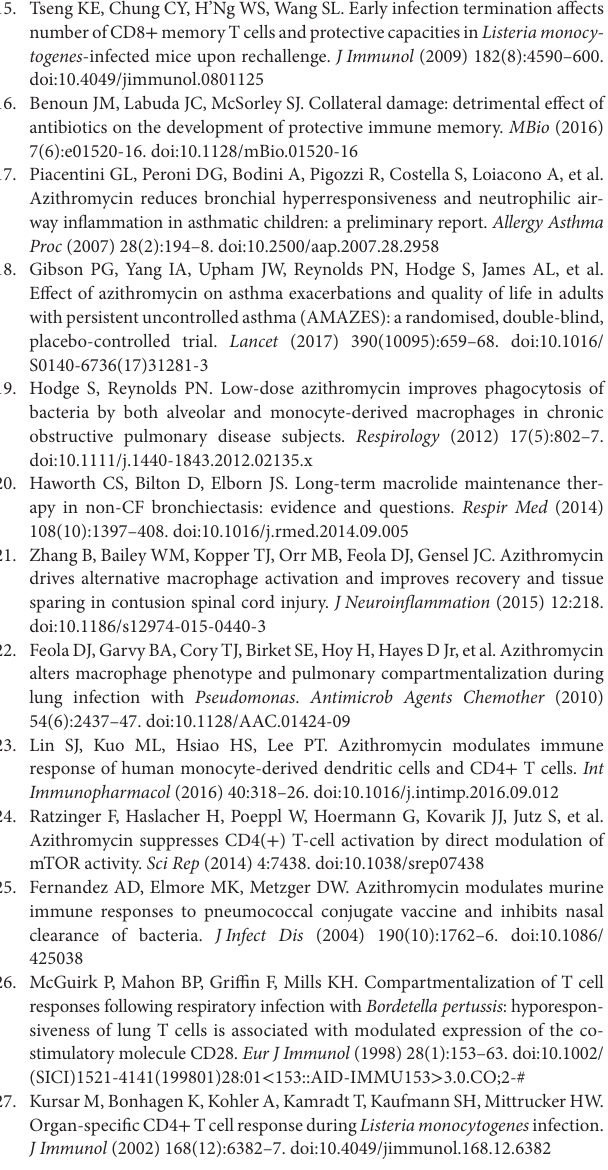
FigUre s1 | Gating strategy for innate immune cell populations. Cells generated by lung digest were antibody stained and analyzed via flow cytometry. After excluding air bubbles at the end of the sample read with a time gate (a) , followed by exclusion of doublets and conglomerates (B) , and cell debris (c) , live cells were determined using a live/dead stain (D) . In the live population, cells were first gated on alveolar macrophages (Siglec F + CD11c + ) and eosinophils (Siglec F + CD11c low ) and the remaining Siglec F − cells (e) . In the Siglec F − population, B cells were excluded as B220 + MHCII + (F) and from the non-B cell population neutrophils were determined as Ly6G + Ly6C + (g) . The non-neutrophil population was split into CD11b + and CD11b − cells (h) . The CD11b + population was split